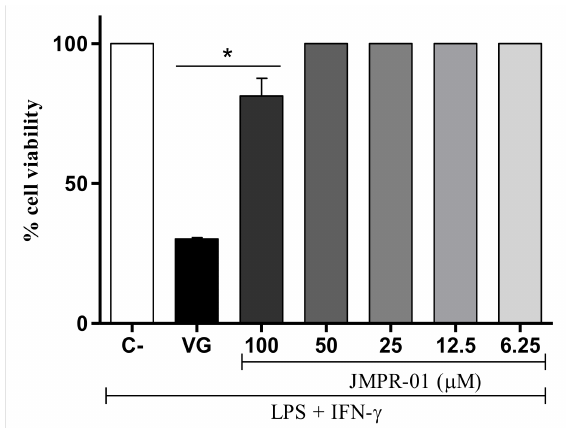
Figure 1. In vitro cytotoxicity of J774 macrophage cell treated with JMPR-01 (6.25–100 µ M). The graph representes cell viability at 72 h determined by Alamar Blue assay. Data representes mean standard erro of the mean ± SEMs; n = 4 determinations per group. * Significantly different from the vehicle treated cultures ( p < 0.05); ANOVA followed by Tukey’s multiple comparison